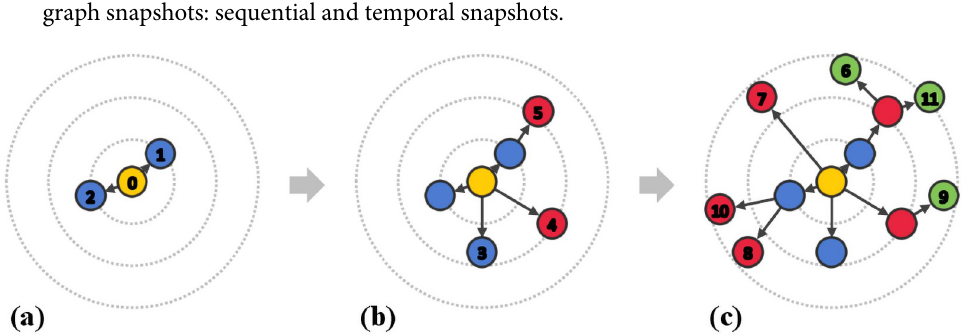
Fig 1. Example of an evolving rumor propagation network where each node represents a post. The link between nodes implies a direct reaction. The numbers in nodes are in the chronological ordering of the generation, and the distance from the root post represents the time interval. The colors depict users’ latent stances on their parent’s post (e.g., neutral (blue), suspect/doubt (red), trust/support (green)). Example scenario: there is an initial claim of Node 0. Node 1, 2, and 3 express neutral stances to the initial claim. Node 4, 5, 7, 8, and 10 express suspect/doubt and Node 6, 9, 11 express trust/support on their parent posts, respectively. Can we identify the veracity label of Node